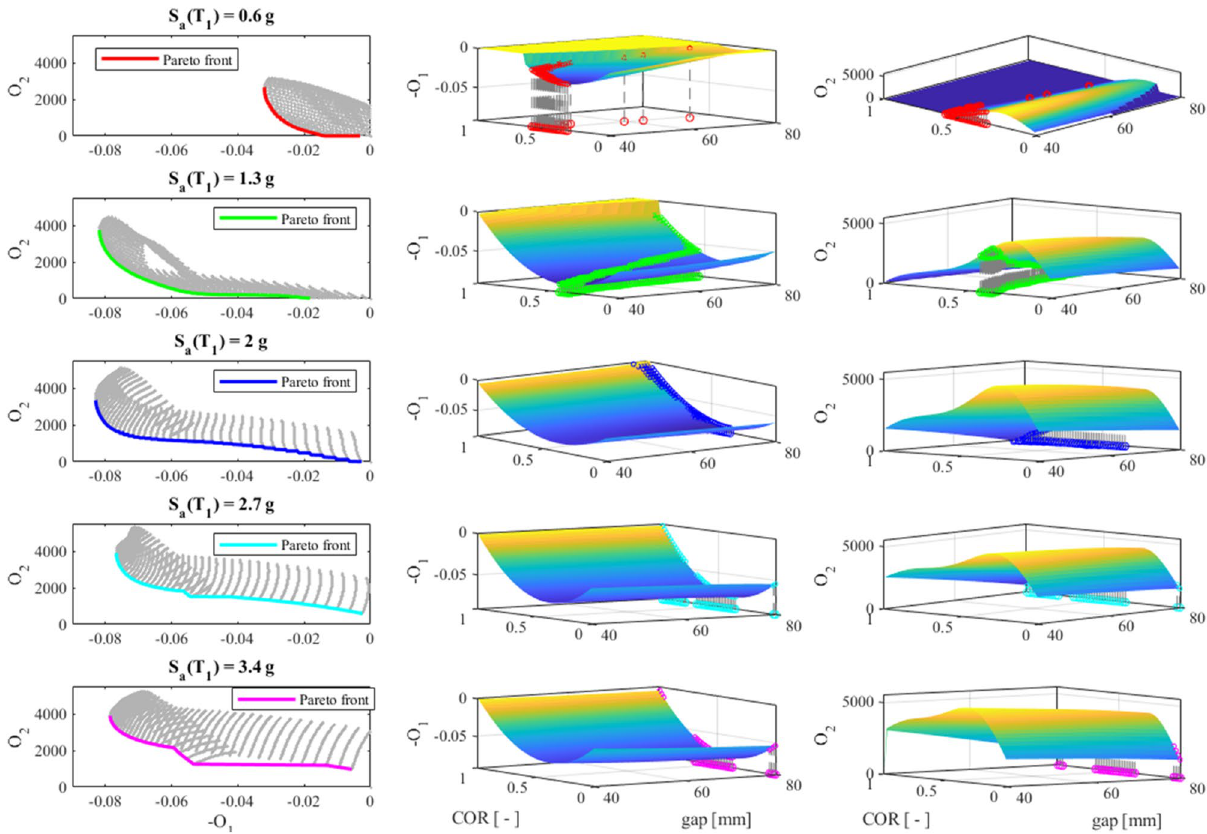
Figure 13. On the left column, each single Pareto front of Fig. 12; on the middle and the right column, the −O 1 and O 2 surfaces,